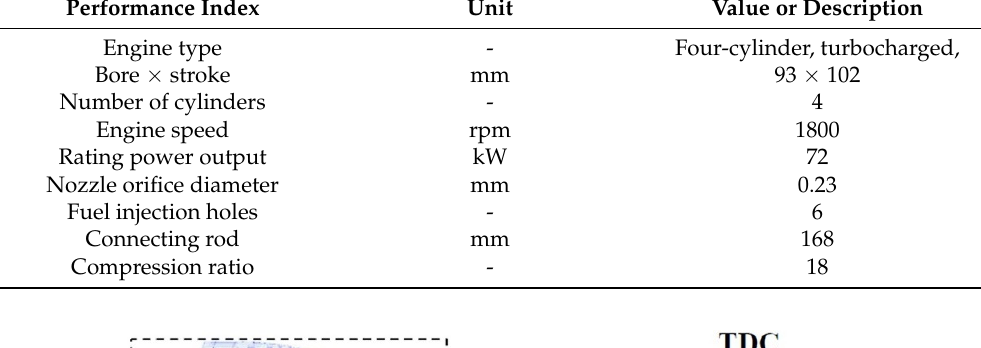
Table 1. Key parameters for the diesel engine.